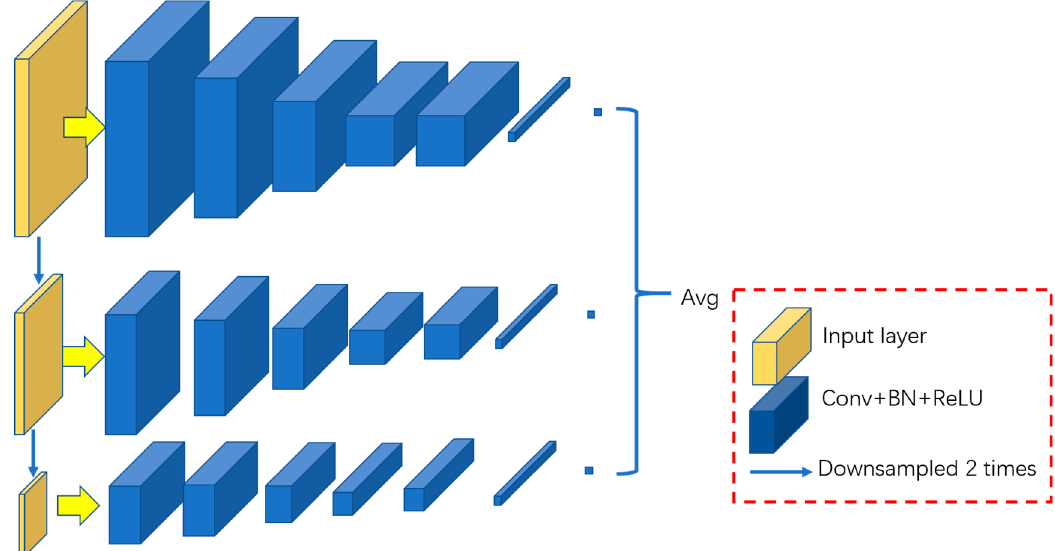
Figure 3. The structure of the multi-scale discriminator.